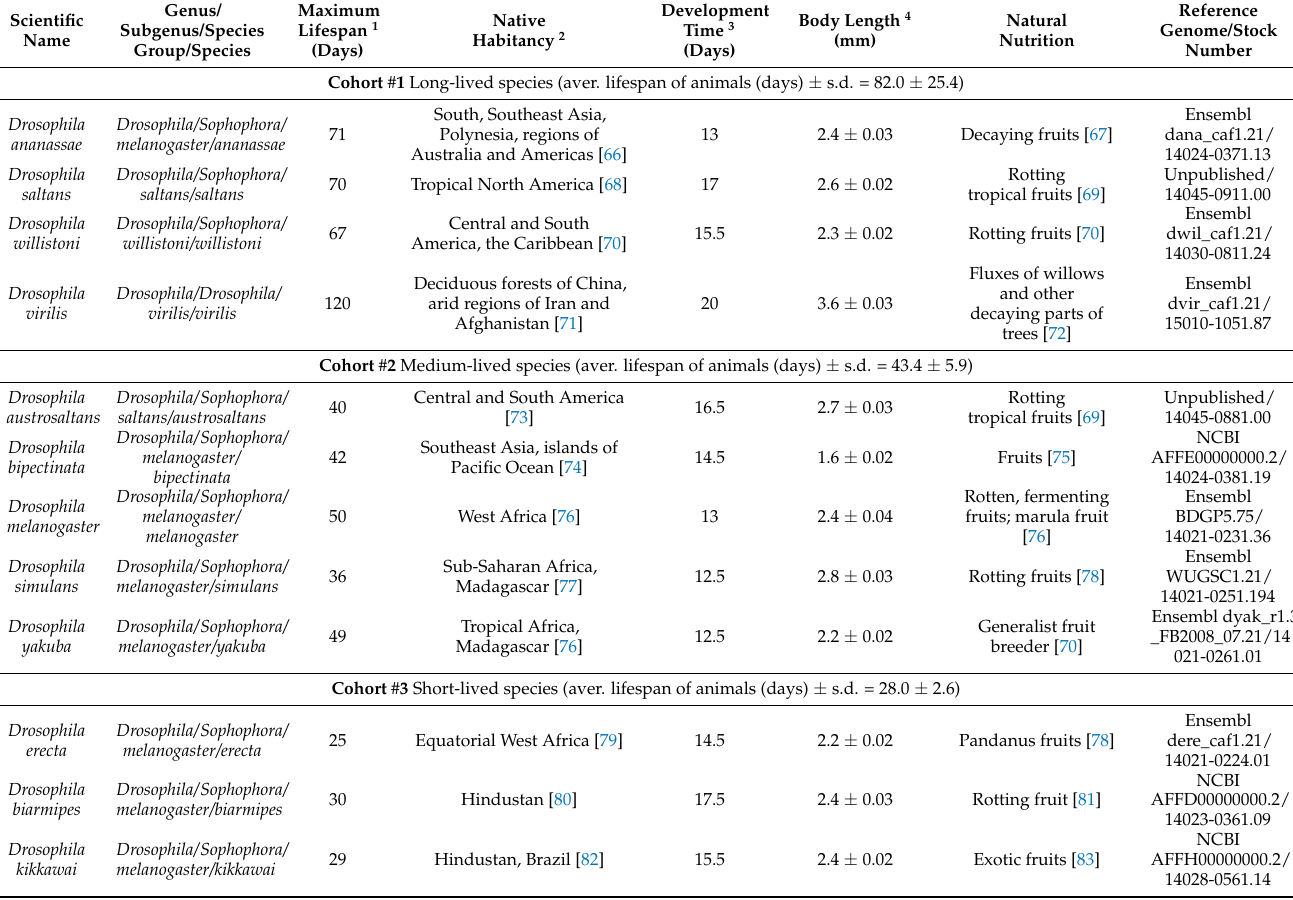
Table 3. Biological characteristics of the 12 fruit fly